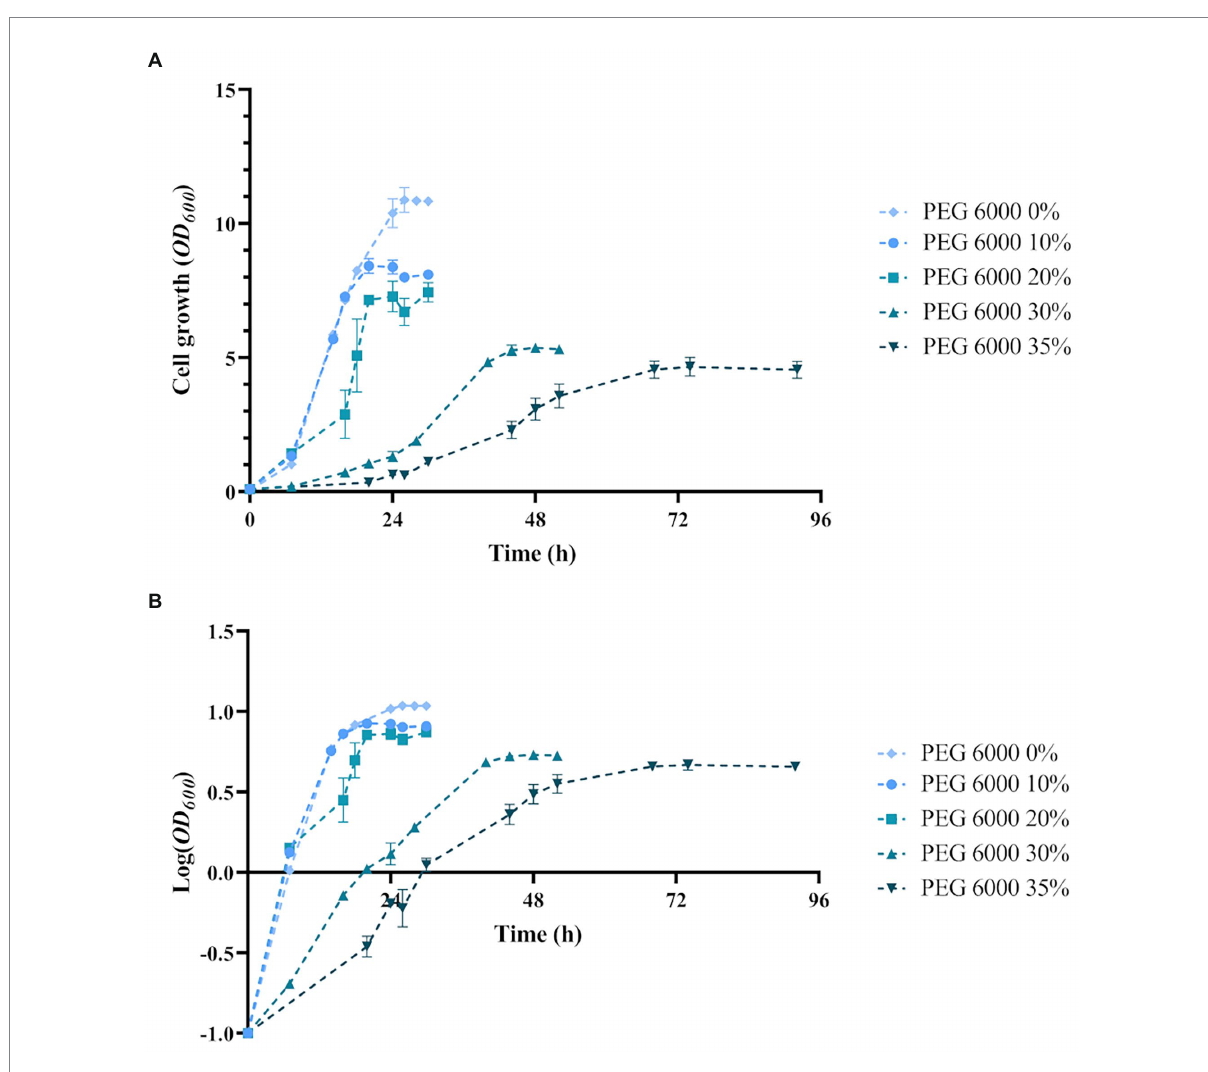
FIGURE 6 Growth of Arthorbacter sp. Helios in LB medium with increasing concentrations of PEG 6000. (A) Growth curve (B) Semilogarithmic representation. Mean and standard deviation of three replicas are